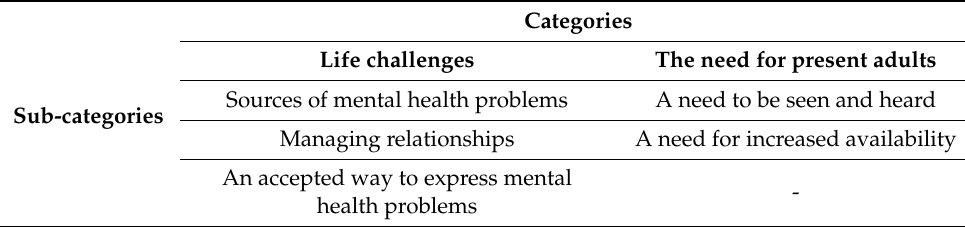
Table 2. Showing the results in terms of categories and